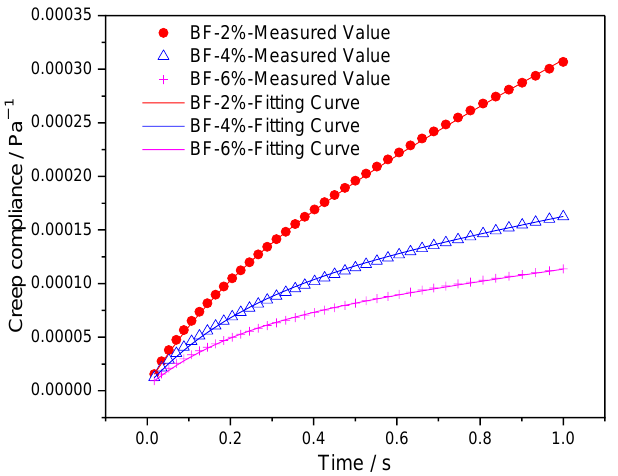
Figure 9. The measured and fitting results of creep compliance for composites with brucite fiber.